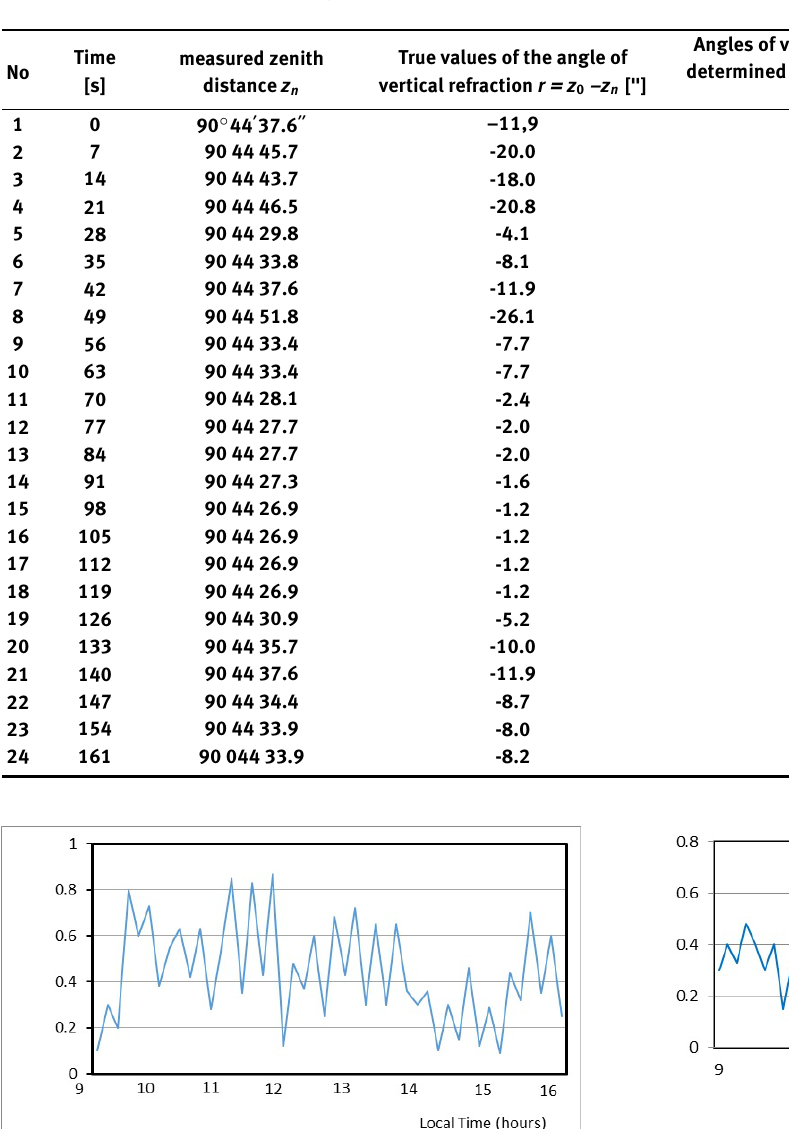
Table 1. Values of the angle of vertical refraction obtained on a line with a length of 642.53 m. True zenith distance z 0 = 90 ◦ 44 ′ 25.7 ′′ . The